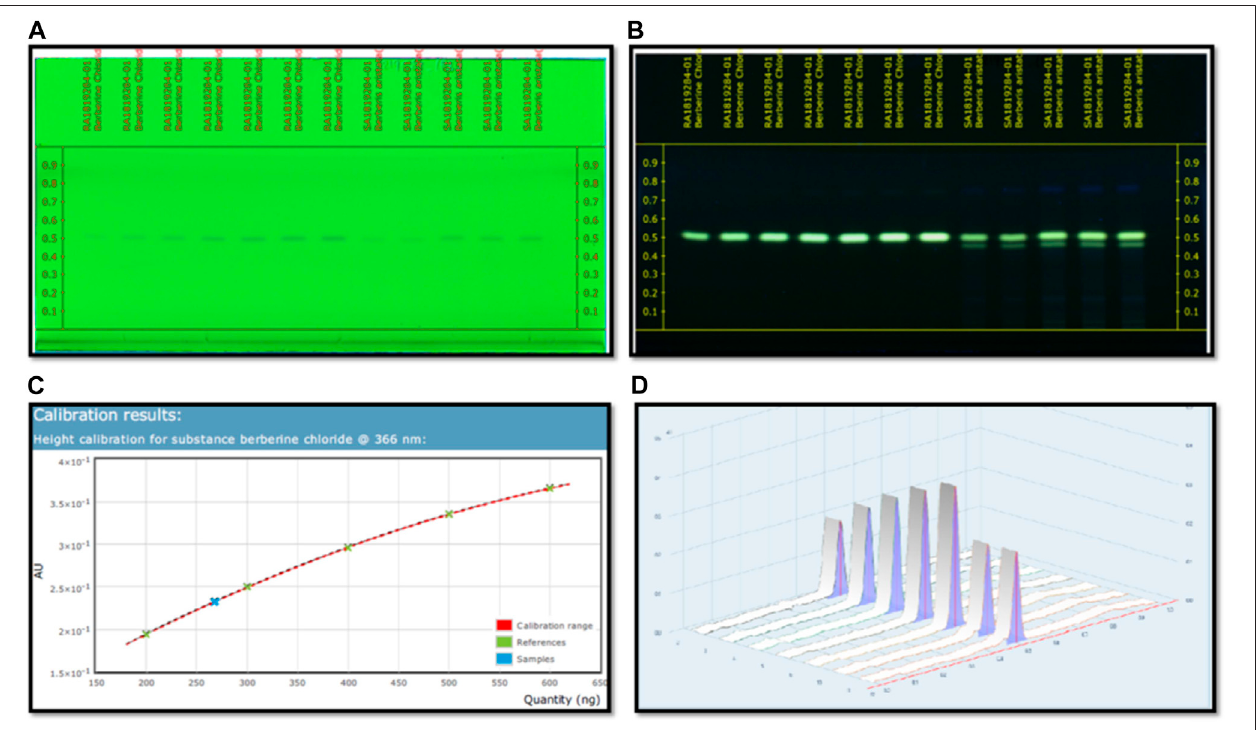
FIGURE 4 | (A) HPTLC fi ngerprinting chromatogram of Berberis aristata at 254 nm. (B) HPTLC fi ngerprinting chromatogram of Berberis aristata at 366 nm. (C) Standard curve of thymoquinone using the polynomial regression mode. (D) Area under the curve in 3D of thymoquinone. (E) HPTLC fi ngerprinting chromatogram of Nigella sativa at 254 nm. (F) HPTLC fi ngerprinting chromatogram of Nigella sativa at 366 nm. (G) Standard curve of thymoquinone using the polynomial regression mode. (H) Area under the curve in 3D of